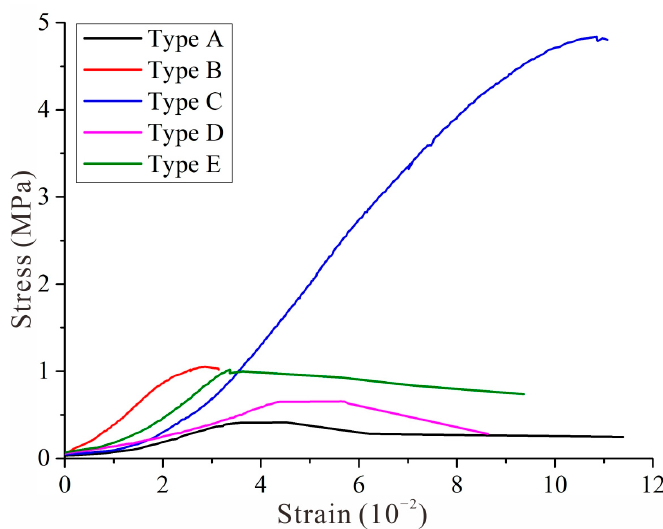
Figure 14. Stress–strain curves.